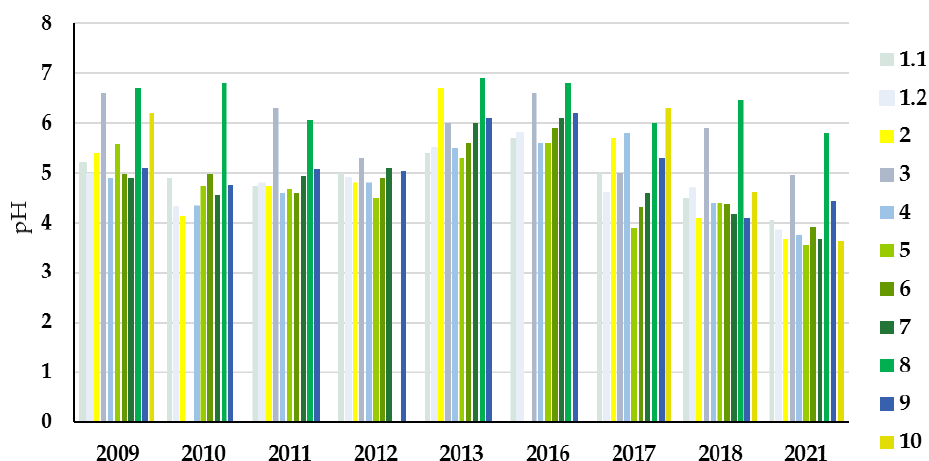
Figure 7. Pore-water pH values in wells during the growing season (May–August) for the observa- tion period.